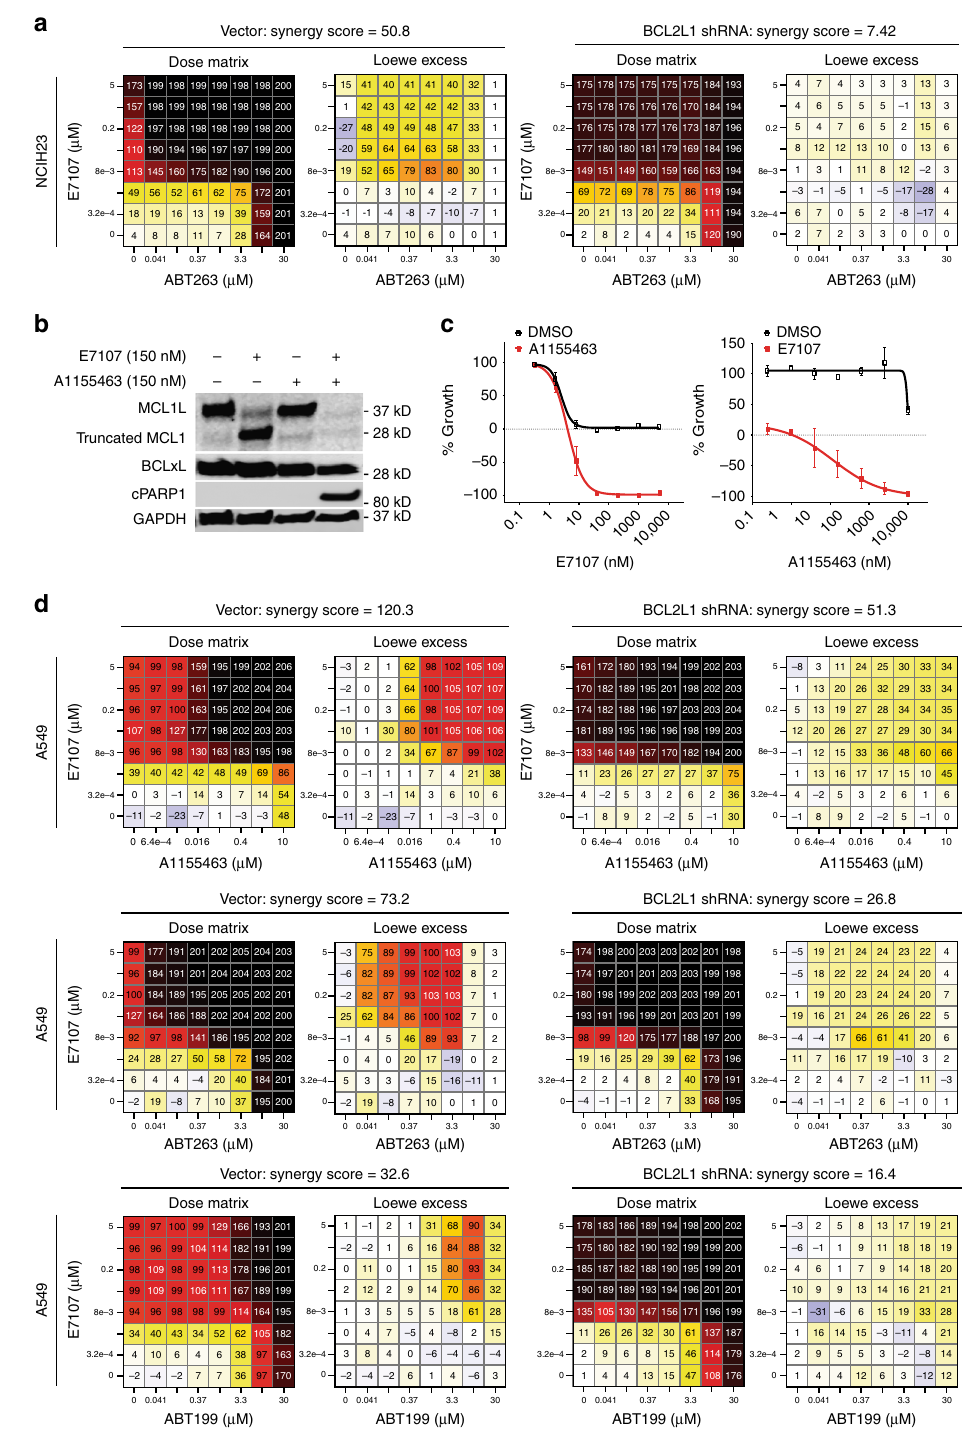
Fig. 6 Combination of splicing modulator E7107 with BCLxL inhibitors induces synergistic cytotoxicity. a 8 × 8 dose matrix combination study for E7107 and ABT263 in MCL1-dependent NCIH23 cells stably transduced with vector control (Vector) or BCL2L1 shRNA. Synergy scores were calculated by the Chalice software (Horizon Discovery). One representative of three independent experiments is shown. b Western blot analysis of MCL1, BCLxL, cleaved PARP1 (cPARP), and GAPDH (loading control) in MCL1-independent A549 cells treated with E7107 or BCLxL-speci fi c inhibitor A1155463. c Growth curves measured by CellTiter-Glo (CTG) in A549 cells treated with single agent (black curves: left, E7107; right, A1155463) or in combination (red curves: left, E7107 + 40 nM A1155463; right, A1155463 + 40 nM E7107). Data represent means ± SD of biological triplicates. d 8 × 8 dose matrix combination study for E7107 and BCLxL/BCL2 inhibitors (A1155463, ABT263, and ABT199) in A549 cells stably transduced with vector control (Vector) or BCL2L1 shRNA. Synergy scores were calculated by Chalice. One representative of three independent experiments is shown